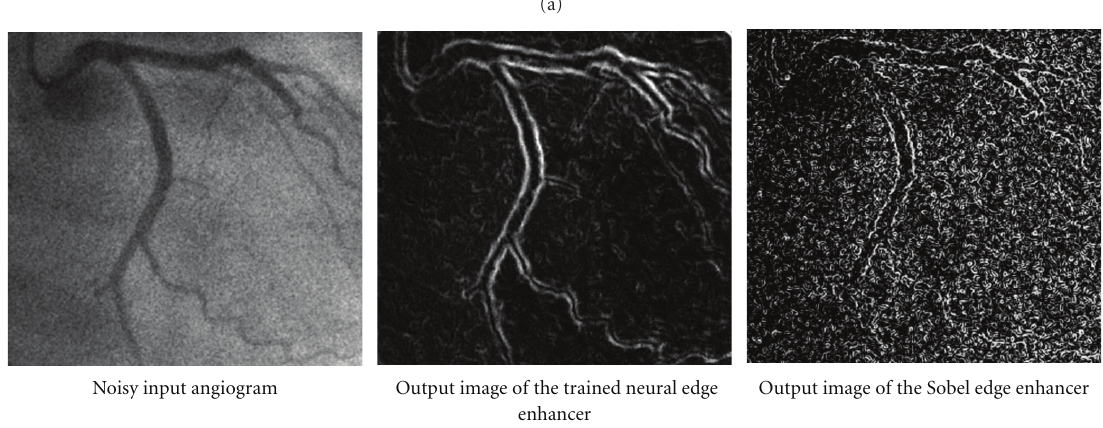
Figure 7: Enhancement of edges from noisy images by use of a supervised edge enhancer called a “neural edge enhancer.” (a) A way to create noisy input images and corresponding “teaching” edge images from noiseless images for training a neural edge enhancer. (b) Result of an application of the trained neural edge enhancer to a nontraining image and a comparison result with a Sobel edge